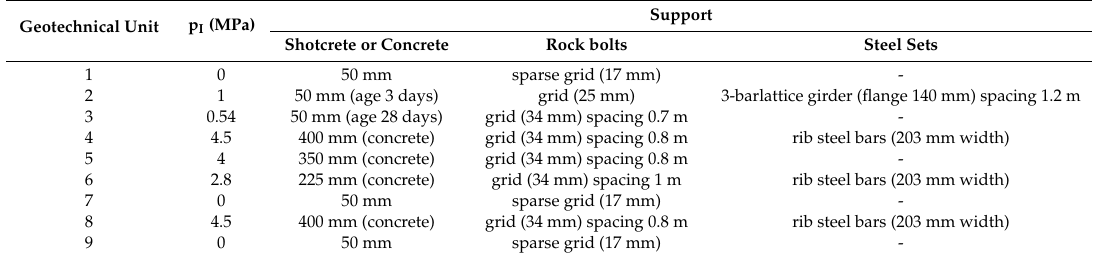
Table 10. Proposed temporary support measures for each Geotechnical Unit.